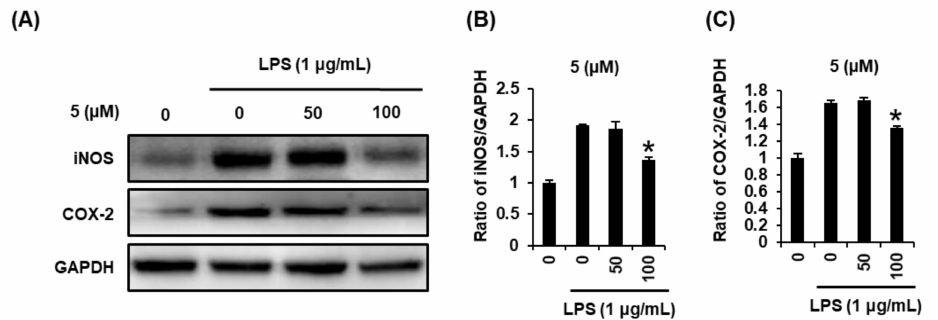
Figure 5. Effects of compound 5 on the expression of inducible nitric oxide synthase (iNOS) and cyclooxygenase-2 (COX-2) in RAW 264.7 mouse macrophages treated with lipopolysaccharide (LPS). ( A ) Representative Western blots showing protein expressions of iNOS, COX-2, and glyceraldehyde-3-phosphate dehydrogenase (GAPDH). ( B , C ) Quantitative bar chart for each protein’s expression level (mean ± SD, * p < 0.05 compared to group treated with 1 µ g/mL LPS